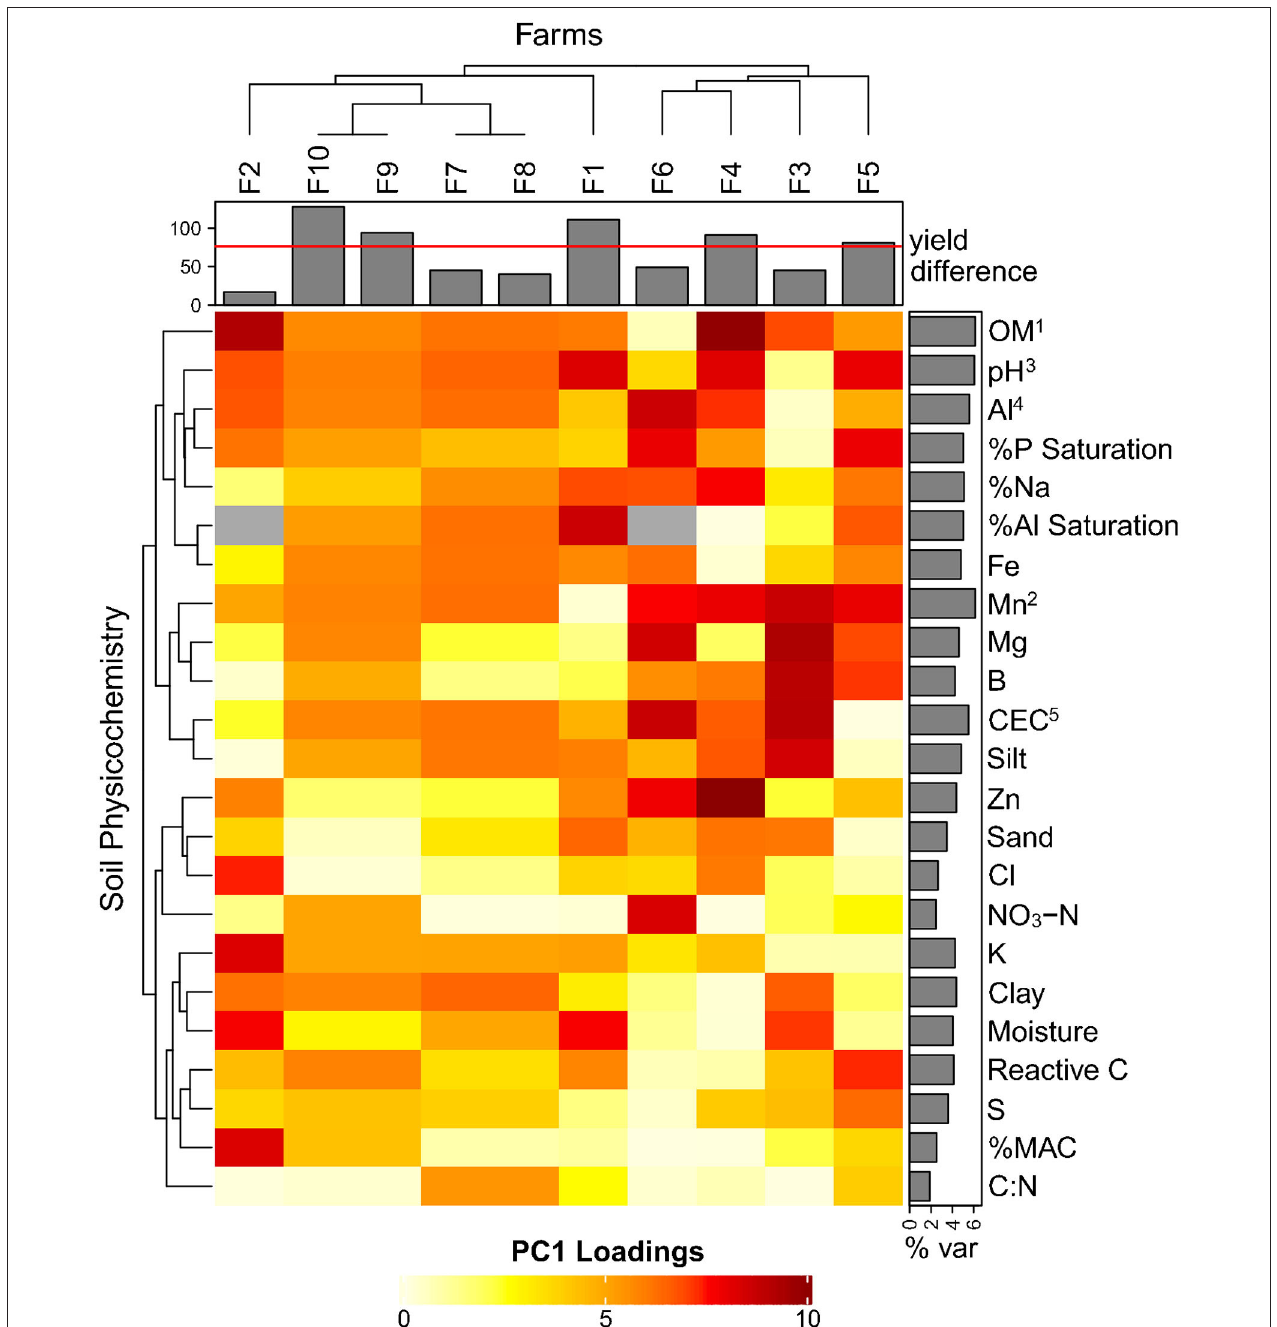
FIGURE 3 | Heatmap of individual farms with PCA-derived loading variables (% explained variation in PC1) for soil physicochemical components (data not shown). The % var row barplot averages each component’s explained variation along the PC1 axis, superscript numbers show the order of the top 5 contributing vectors. The column barplot shows the yield differences for each farm (high—low) with a cut-off line at 80 bu/ac (5.38 t/ha) identifying substantial yield differences. N/A values are in gray.